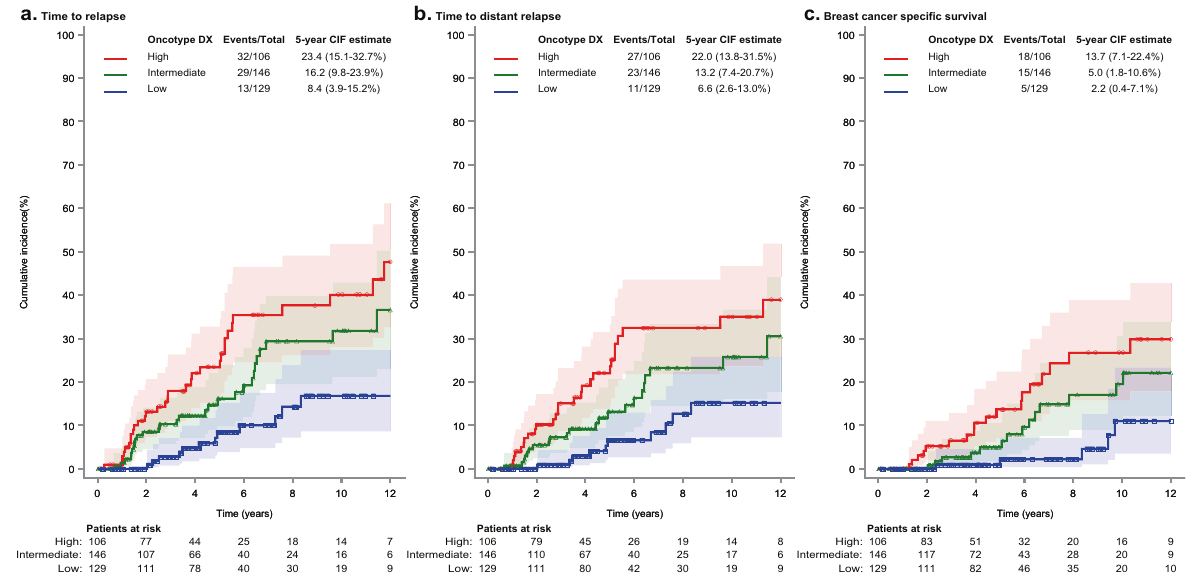
Fig. 1 Oncotype DX-trained cumulative incidence of clinical outcomes by risk category. a Oncotype DX-trained risk classi fi cation for Time to Relapse; b Oncotype DX-trained risk classi fi cation for Time to Distant Relapse; c Oncotype DX-trained risk classi fi cation for Breast Cancer Speci fi c Survival. Cumulative incidence rates for low (blue line), intermediate (green line), and high (red line) Oncotype DX-trained results with corresponding 95%CI (shaded areas) estimated by cumulative incidence function accounting for deaths not preceded by a distant relapse as competing risks. Total events/risk group (Events/Total) represent all events observed during follow up (up to 12 years). CIF = 5-year cumulative event frequency (percent) at 5 years with estimated 95% con fi dence intervals (95%